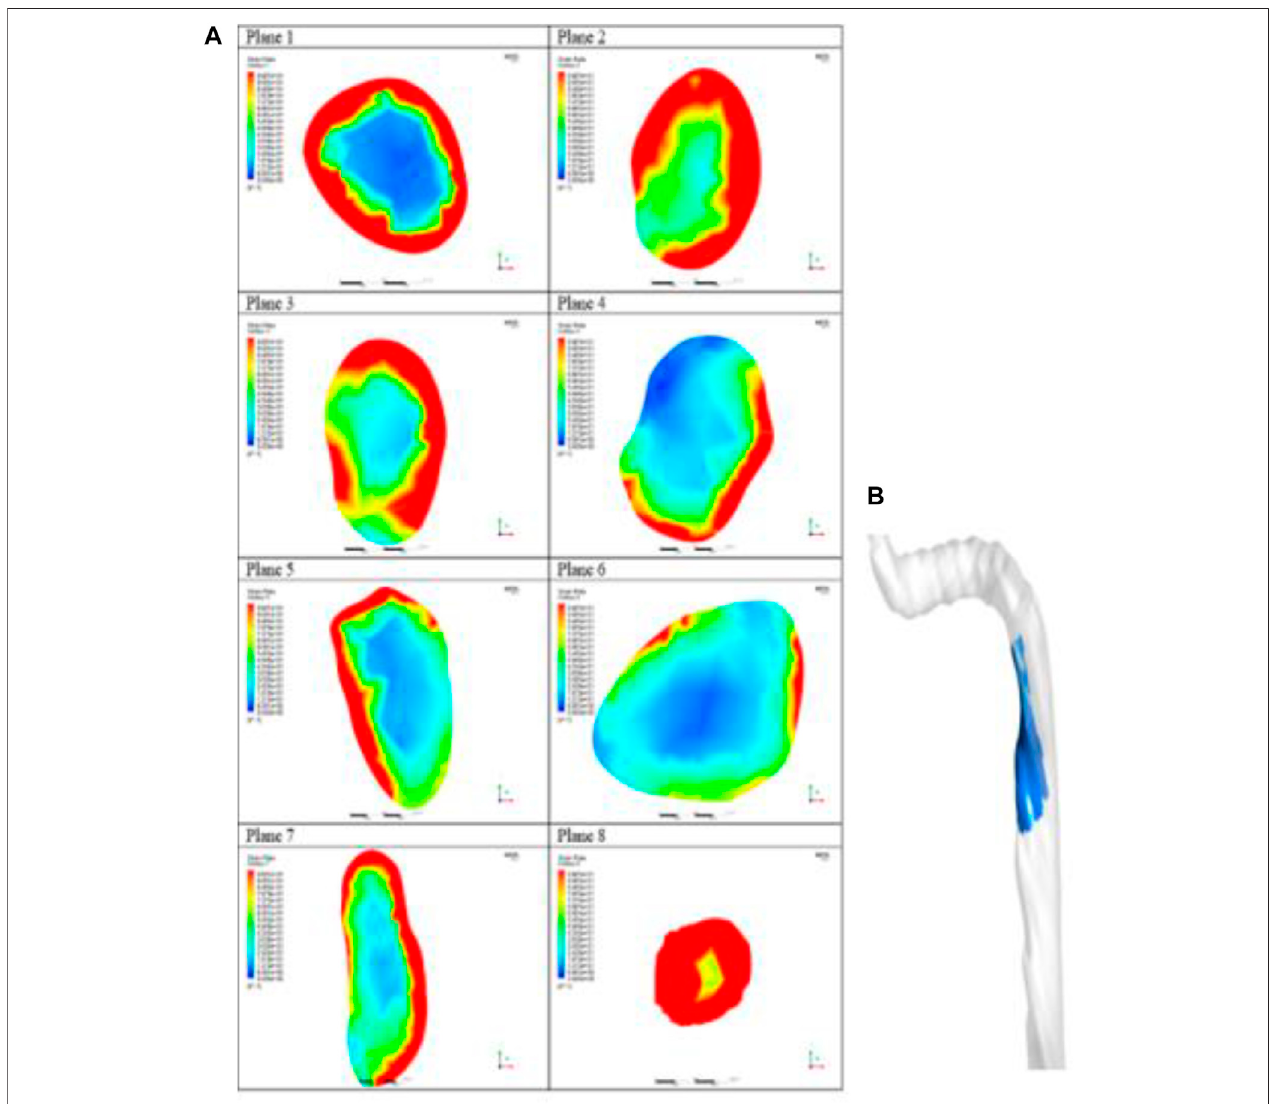
FIGURE 12 | (A) Strain rate contours on the planes of interest and (B) position of injury zone used for simulations in the patient-speci fi c model.